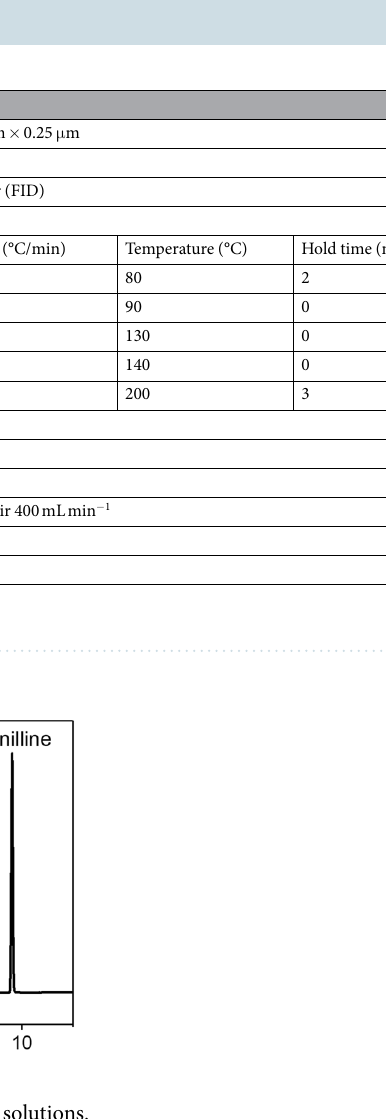
Figure 1. Gas chromatogram of mixed standard solutions.